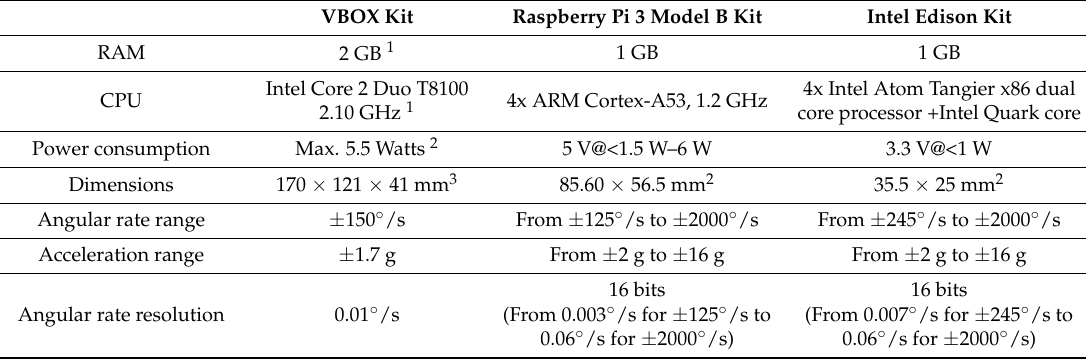
Table 1. Technical specifications of hardware elements included in the